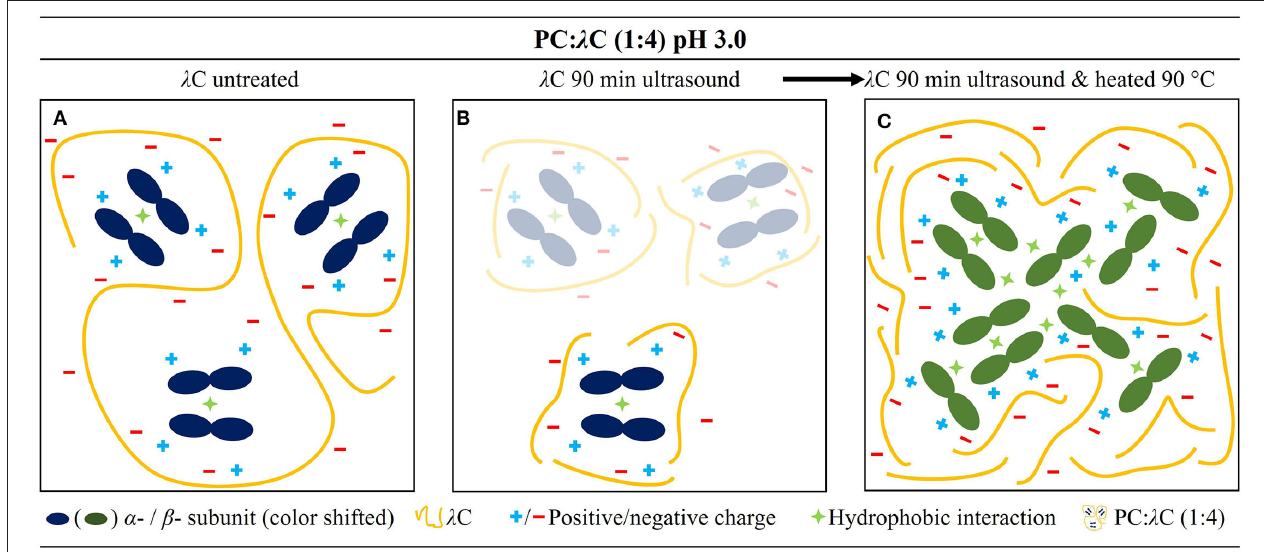
FIGURE 5 | Mechanistic drawing of the PC: λ C complex at a pH of 3.0. (A) Complex prepared with 0min ultrasonicated λ C, (B) prepared with 90min ultrasonicated λ C, and (C) complex prepared with 90min ultrasonicated λ C which was heated to 90C.